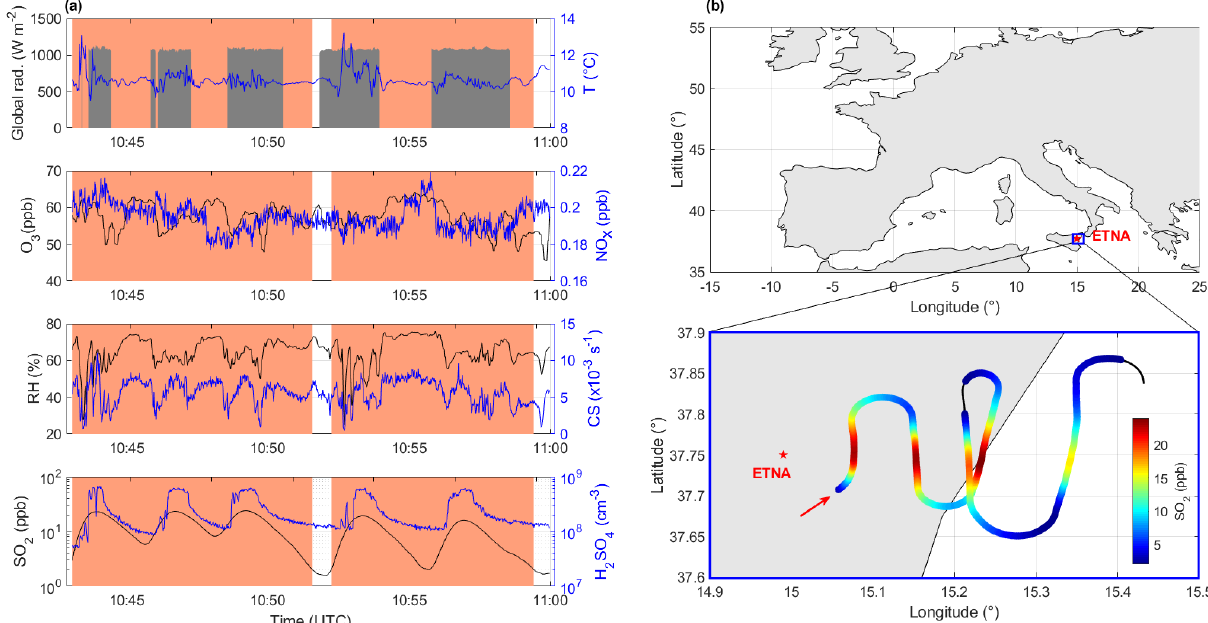
Figure 2. Overview of the conditions during the first part of the ETNA 13 flight. (a) Similarly to Fig. 1, measurements performed under plume conditions are highlighted by the red shaded areas. Note that with the exception of radiation, which is represented by the grey area in the top panel, the black line represents the variable on the left y axis, and the blue line represents the variable on the right y axis in all other panels. (b) Map of the flight. The location of the plume is illustrated by the SO 2 levels reported on the coloured path, for which the direction is further indicated by the arrow. The red star indicates the position of the vent.